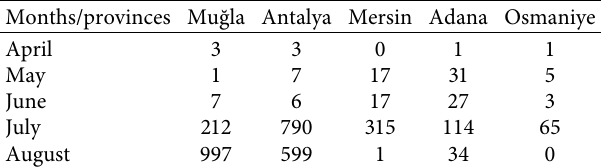
Figure 2: Monthly forest fre events according to the provinces. Table 2: Historical events of fre forest in